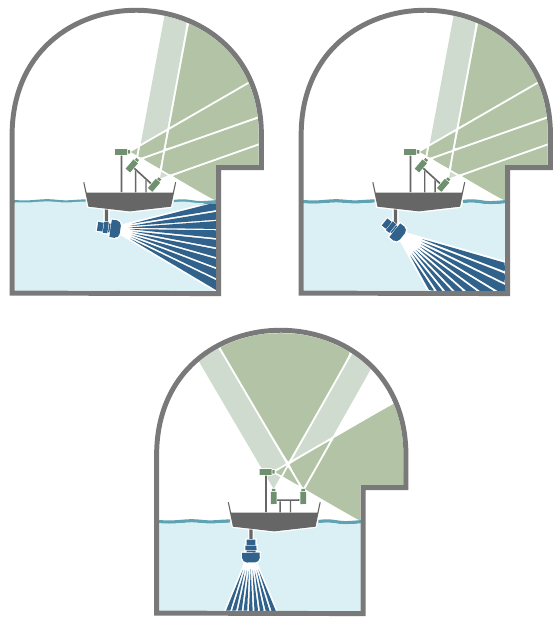
Figure 3. Schematic views of the three system configurations used for scanning a half tunnel.